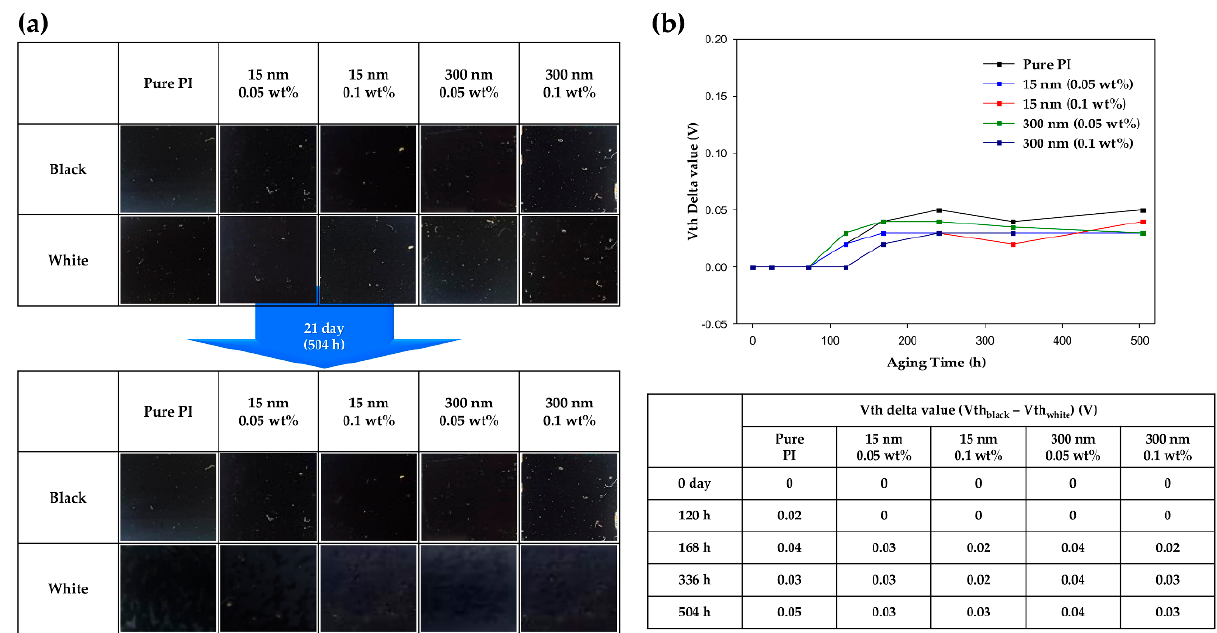
Figure 8. ( a ) Photographic images to evaluate the long-term stability of the LC cells fabricated using pure polyimide and hybrid polyimide over 504 h. ( b ) Difference between the threshold voltages in the white and black states over time.